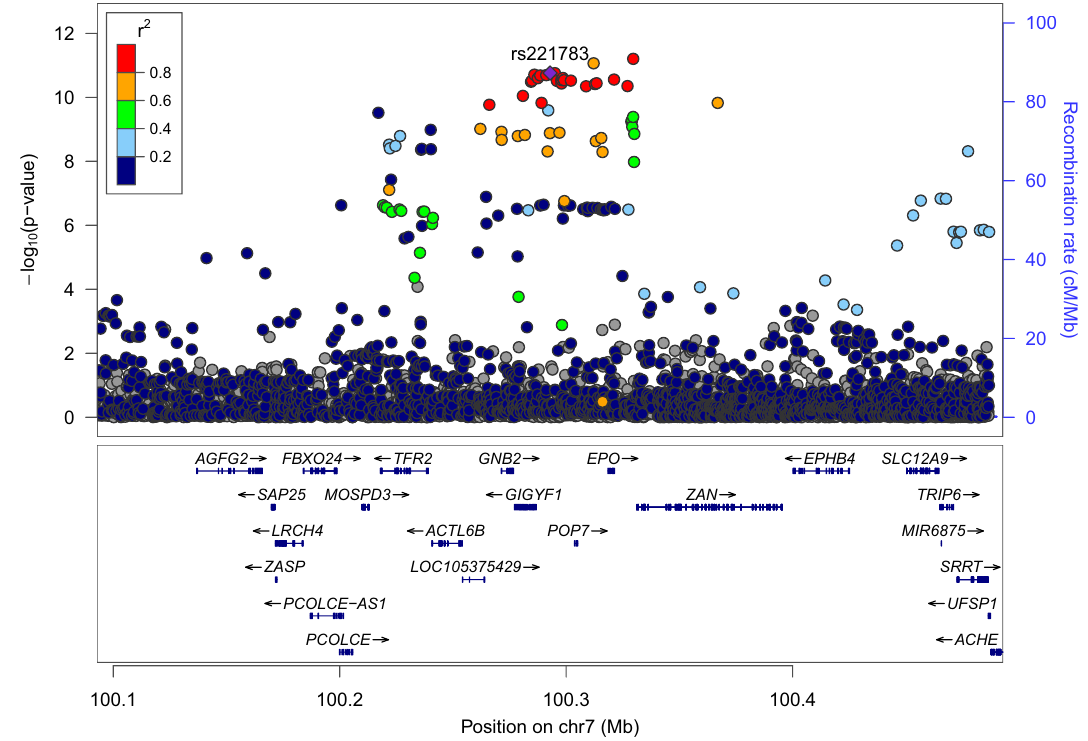
Figure 4. Locus plot of glucose associations at the GIGYF1 locus. Association results for array genotyped and imputed variants are shown. The purple diamond represents the lead variant rs221783. Other variants are colored according to correlation (R 2 ) with this marker (legend at top-left). The region displayed is chr7: 100092914–100492914. Genomic coordinates are for hg19.